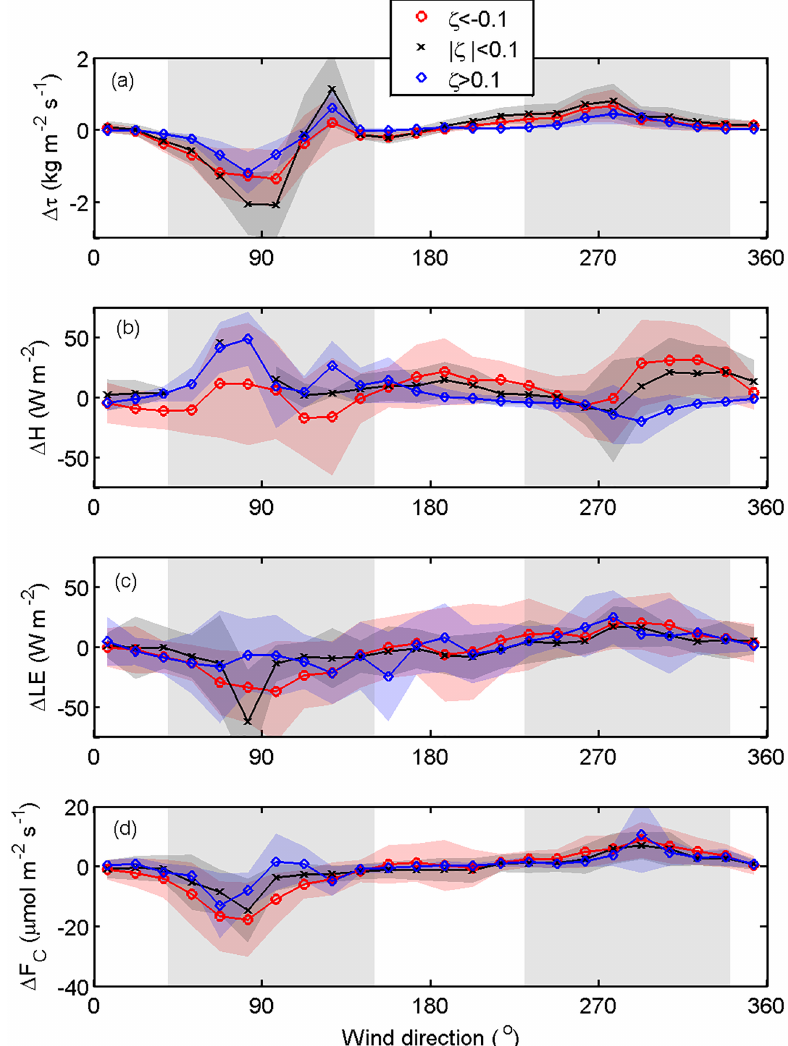
Figure 4. Wind direction dependence of the differences in the (a) momentum ( τ ), (b) sensible ( H ) and (c) latent heat (LE), and (d) CO 2 ( F C ) fluxes between the two EC systems (EC1–EC2). Differences are calculated for the whole measurement period, and data are separated into different stability classes (unstable ( ζ < − 0 . 1), stable ( ζ > 0 . 1) and neutral ( | ζ | < 0 . 1)) based on the stability parameter ζ . Lines and symbols represent the 15 ◦ bin averages, and the shaded areas ± 1SD. The neglected wind directions (40–150 ◦ for EC1 and 230–340 ◦ for EC2) are marked with grey